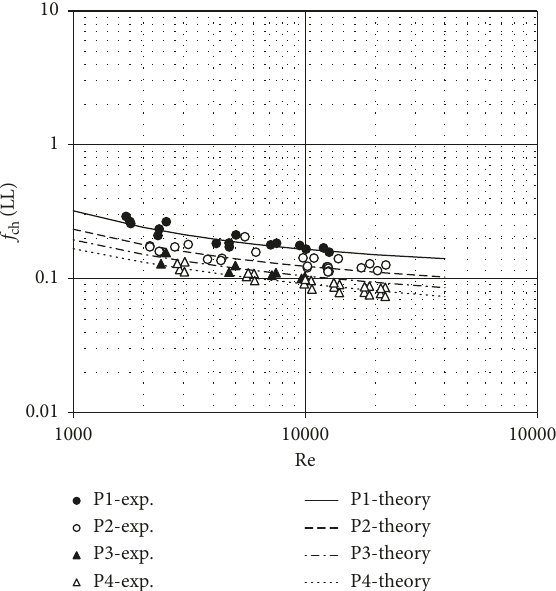
ch (LL) for plates P1–P4 with LL